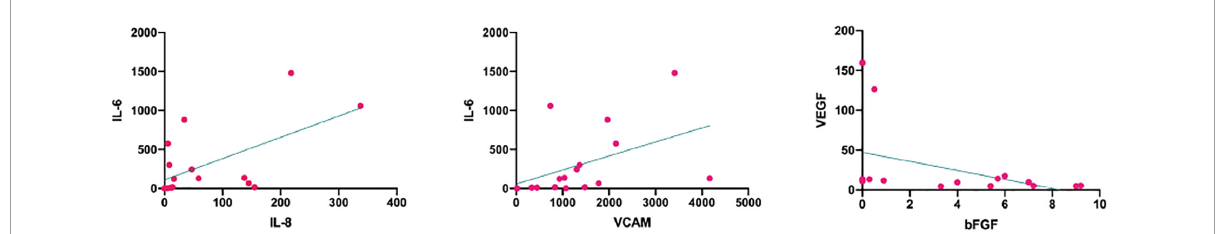
FIGURE2 Correlations between the cytokines in the two groups. IL-8 and IL-6 ( ρ = 0.5412, p = 0.0304) and IL-6 and VCAM ( ρ = 0.5853, p = 0.0172) were significantly positively correlated. bFGF and VEGF ( ρ = –0.4978, p = 0.0497) were significantly negatively correlated. bFGF, basic fibroblast growth factor; IL, interleukin; VCAM, vascular cell adhesion molecule; VEGF, vascular endothelial growth